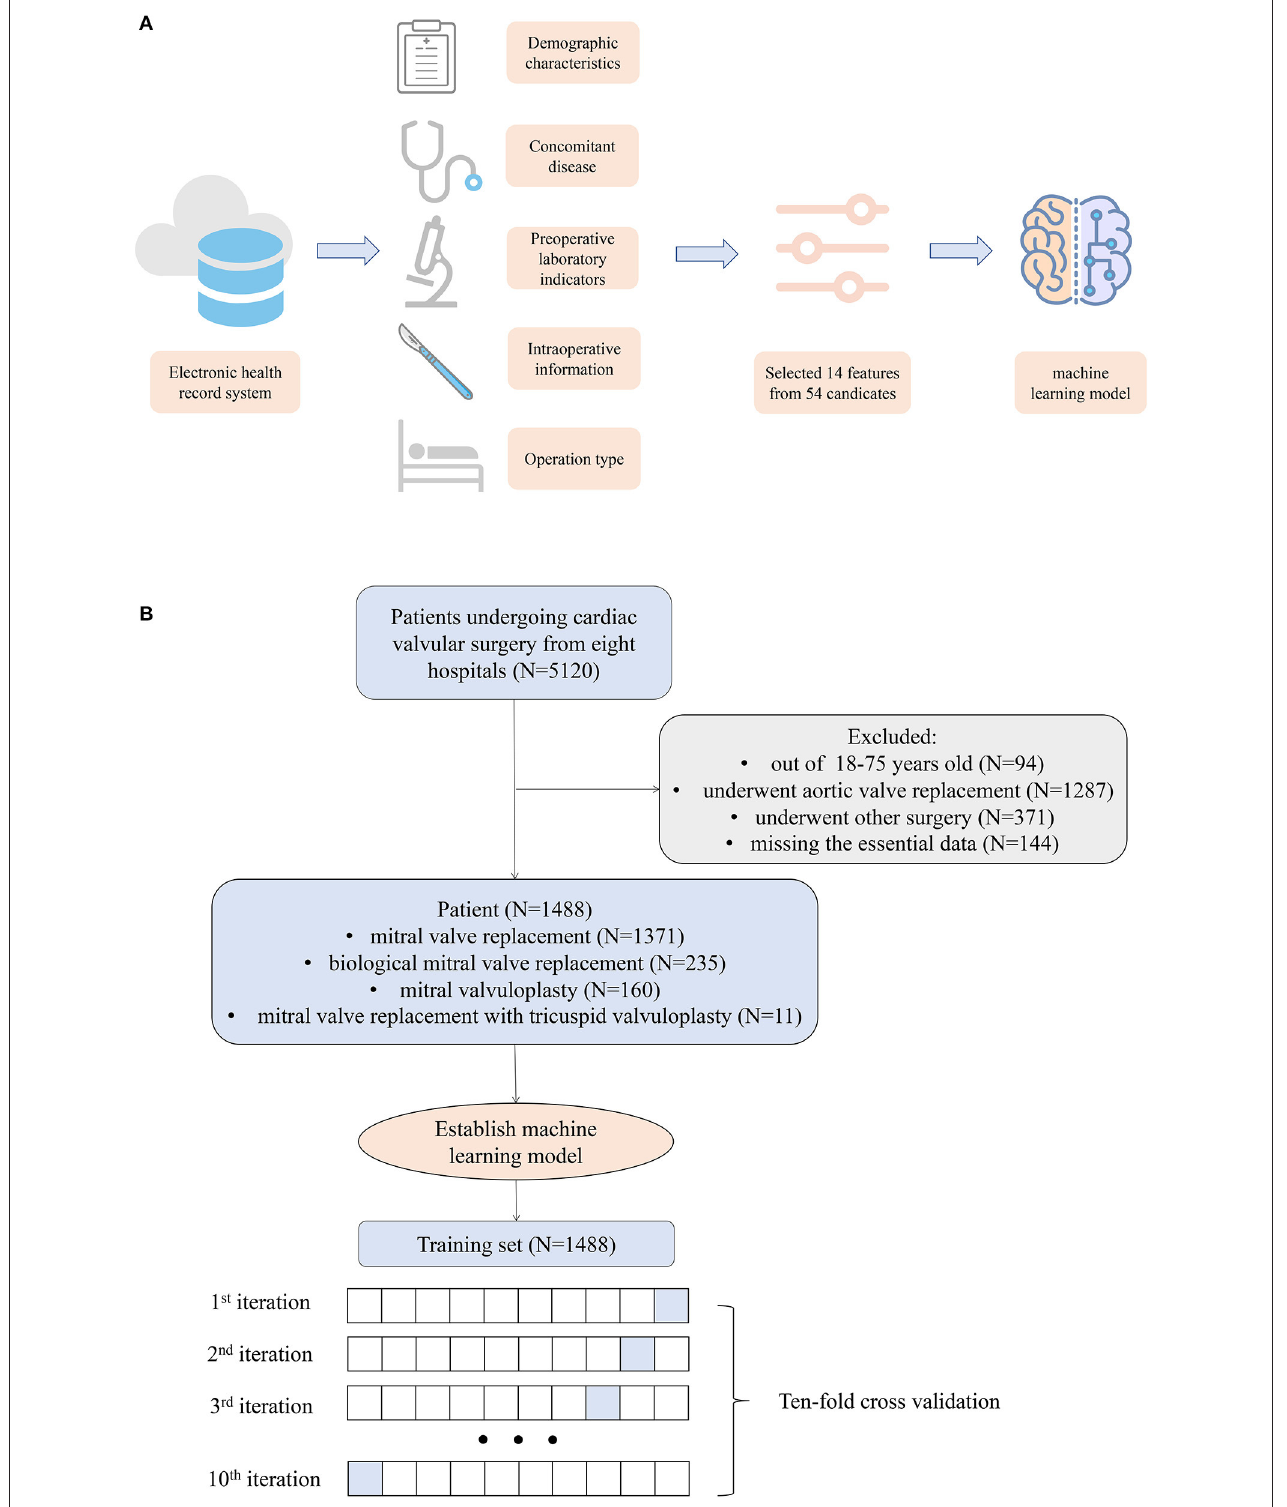
FIGURE 1 | (A) Workflow of the study. (B) Flow chart of patient selection.